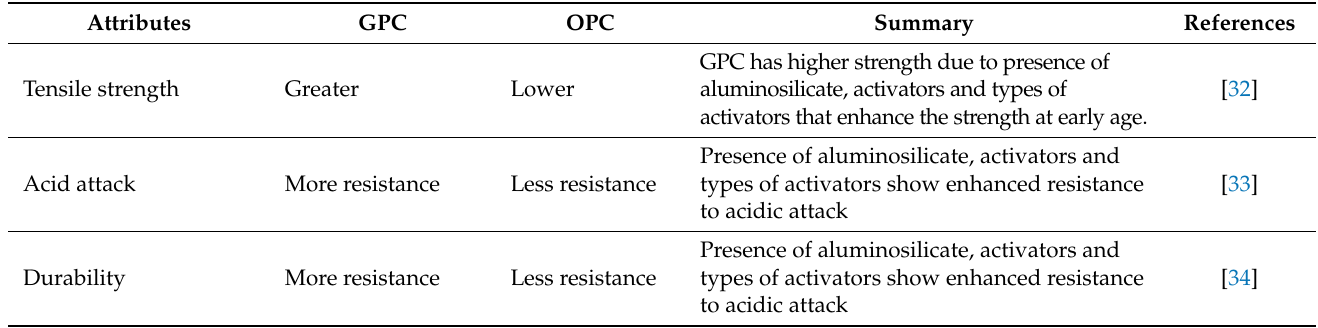
Table 1. Comparison of GPC with